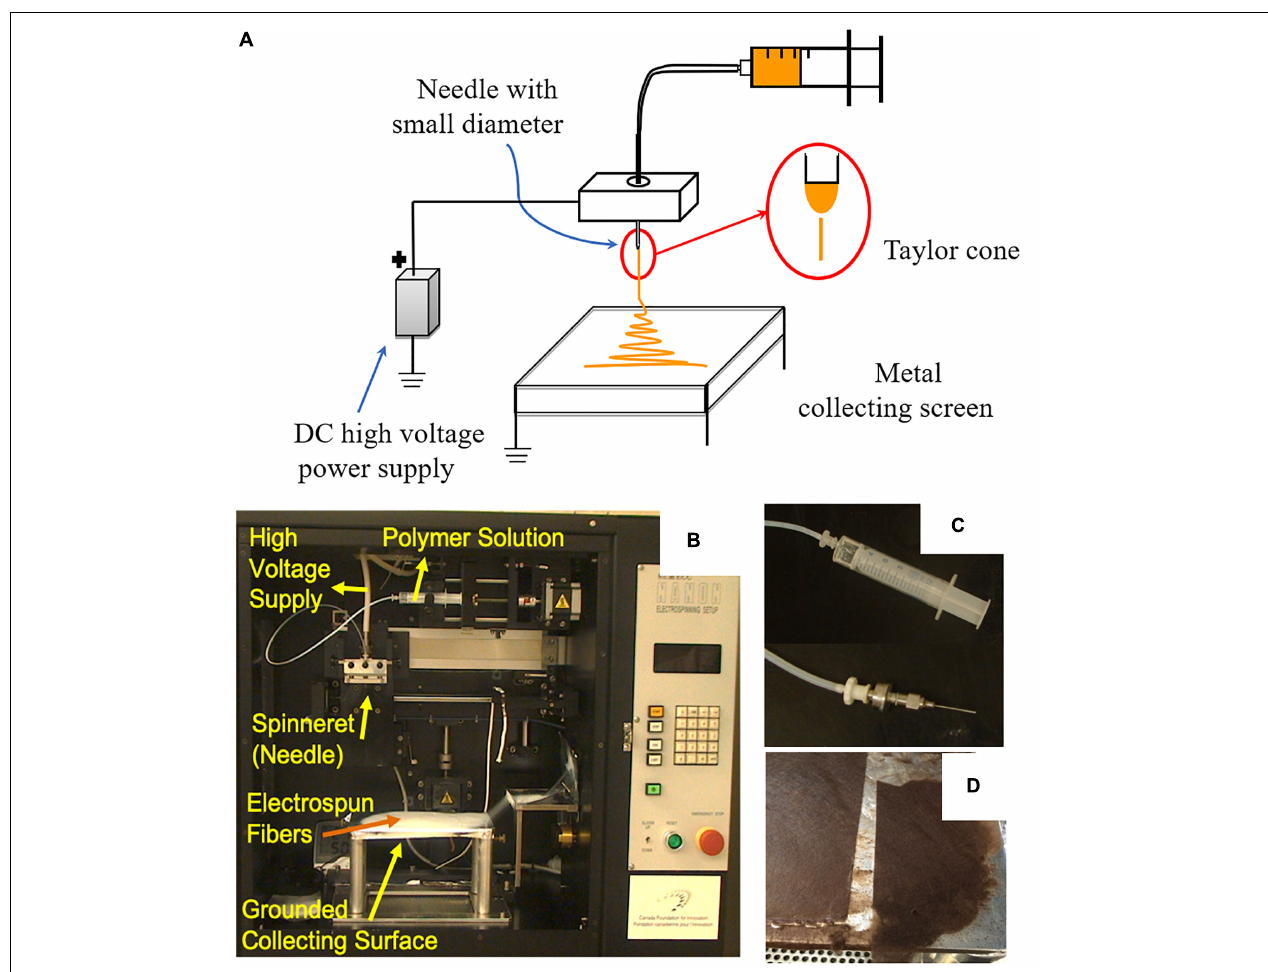
FIGURE 3 | (A) Schematic diagram of electrospinning set up (vertical set-up) reproduced from Poursorkhabi (2016); (B) Front view of a commercial electrospinning machine showing the main parts of the process [NANON-01, MECC Co. (Japan)]; (C) Needle and syringe connections and (D) Sample of collected lignin fibers on a flat collector ( B–D are original pictures from the Bioproducts Discovery and Development Centre).